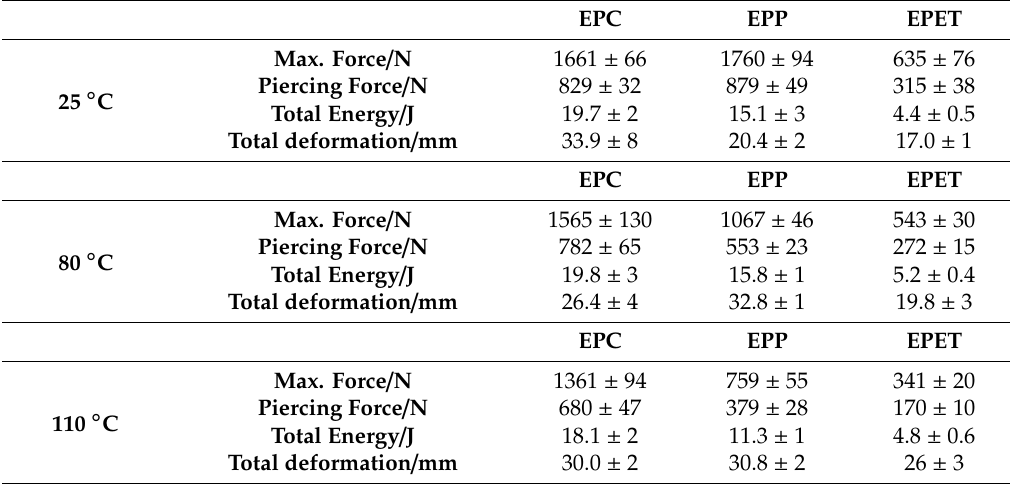
Table 5. Summary of impact characteristic values for EPC, EPP, and EPET at RT, 80, and 110 ◦ C.